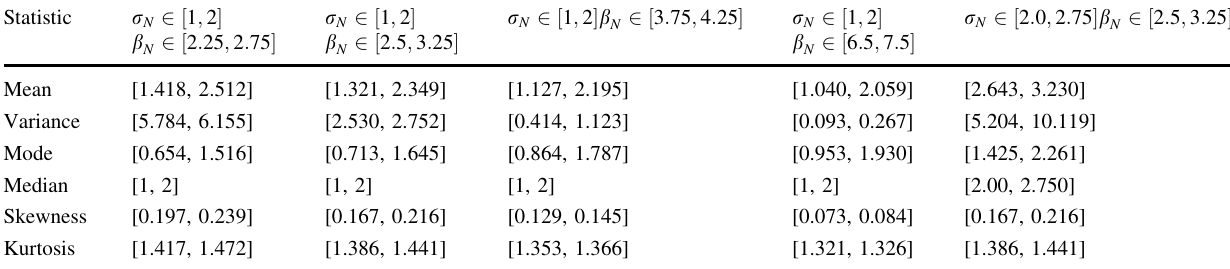
Table 1 The Neutrosophic statistical constants of NLLD